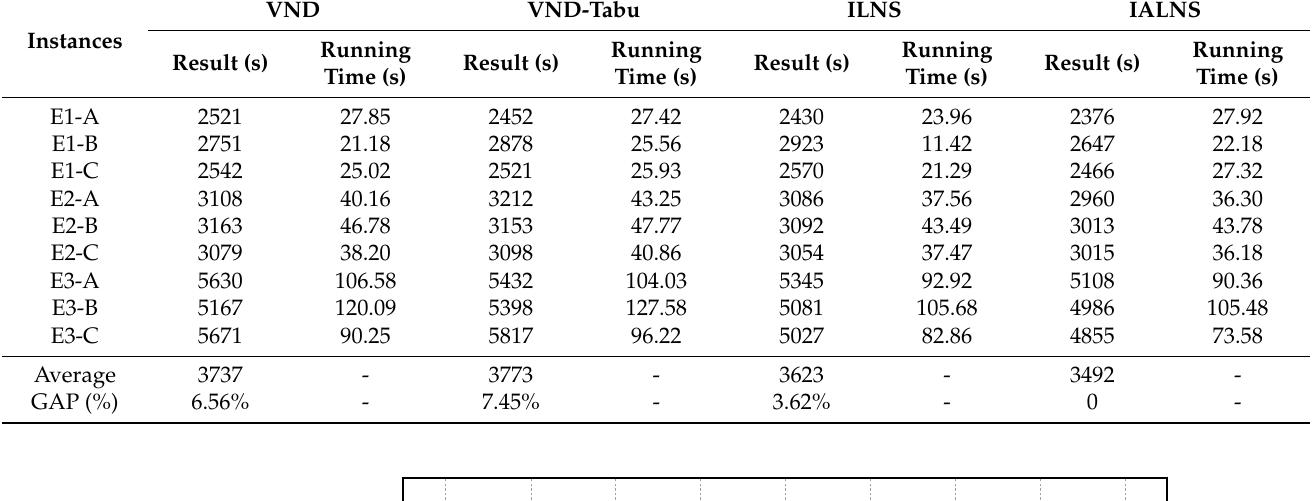
Table 5. comparison algorithms.